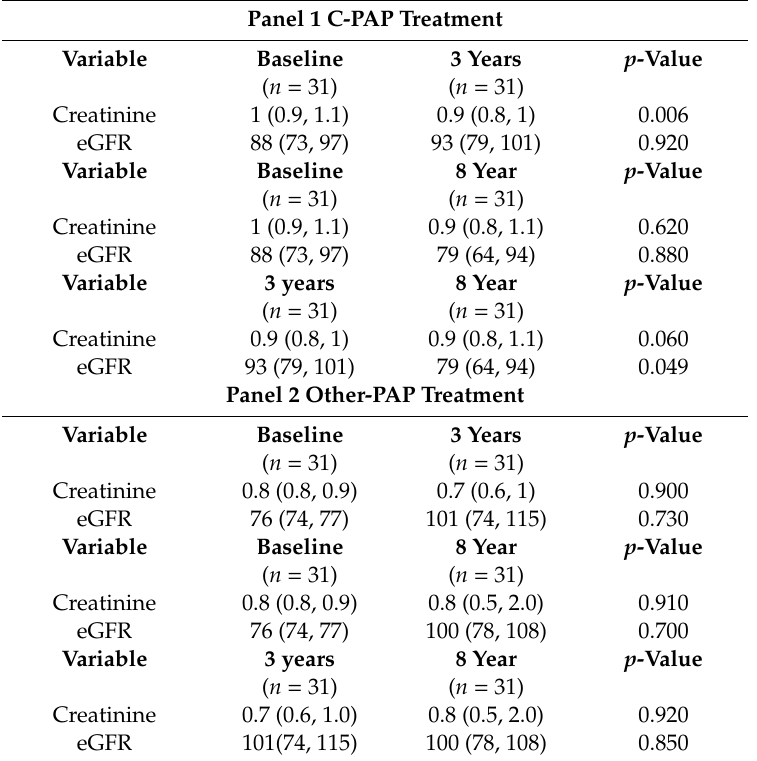
Table 3. Descriptive table of outcome in C-PAP (Panel 1) and other-PAP data (Panel 2).